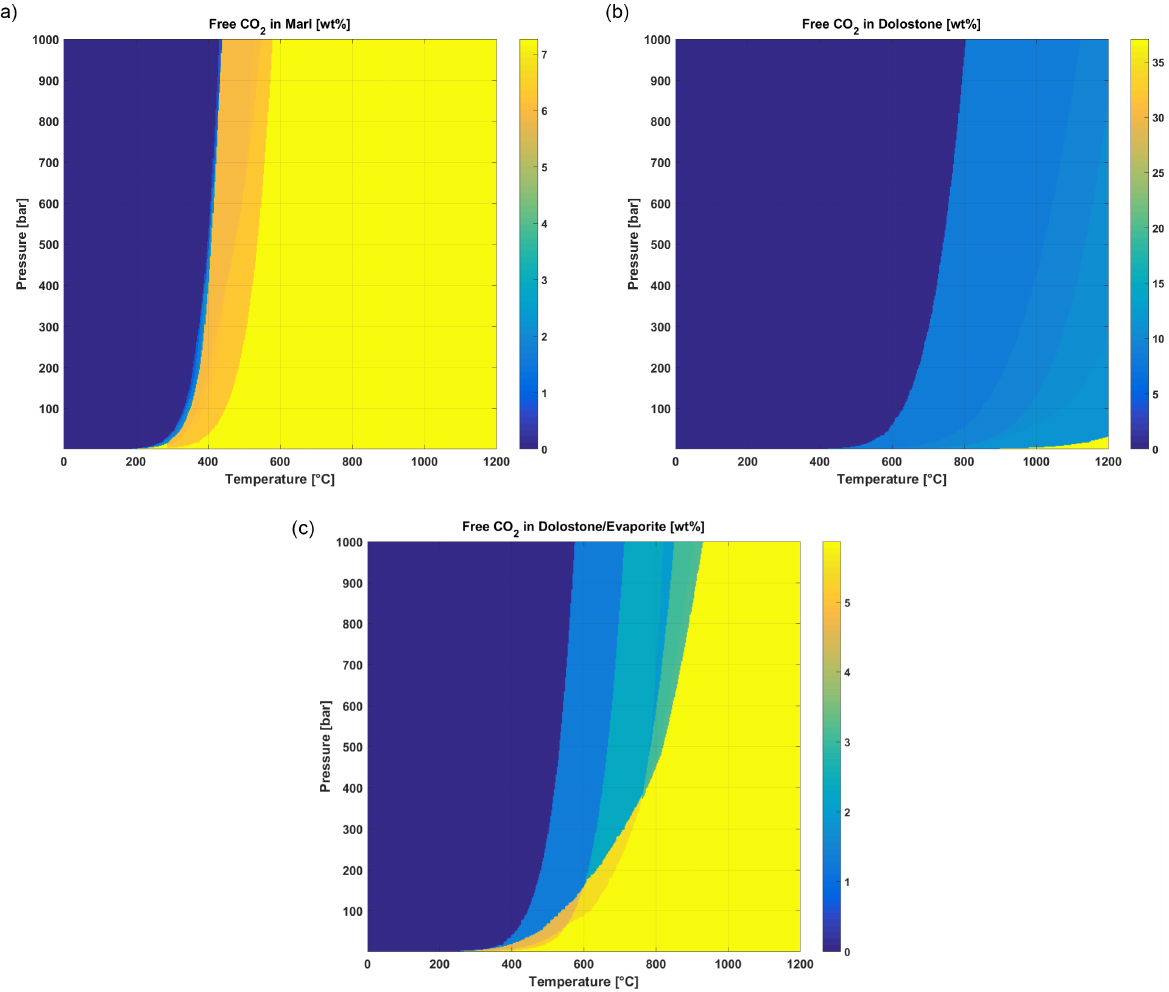
Figure 1. Phase diagrams generated by Perple_X showing the amounts of inorganic CO 2 liberated with respect to temperature and pressure for marl (a) , dolostone (b) and dolostone/evaporite (c)